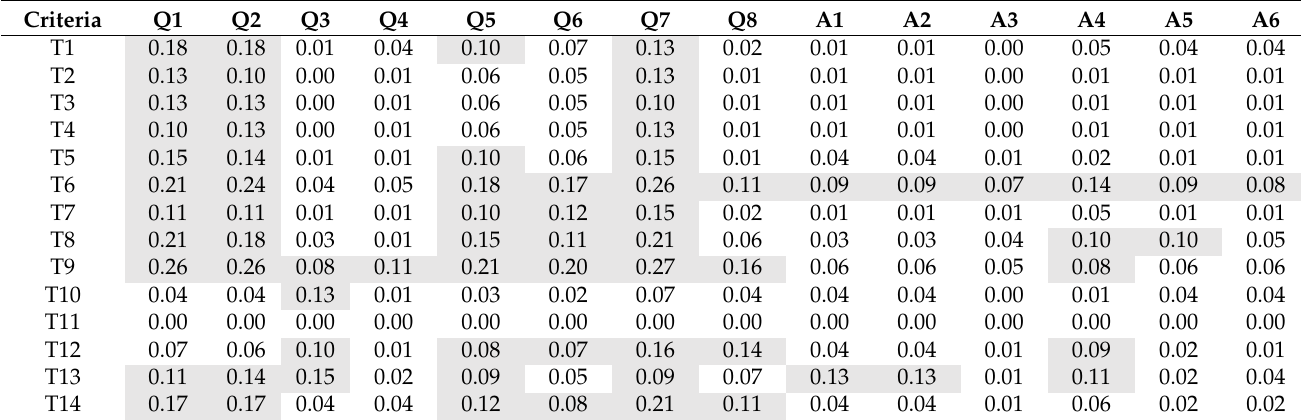
Table 5. Key PV criteria. Own study.